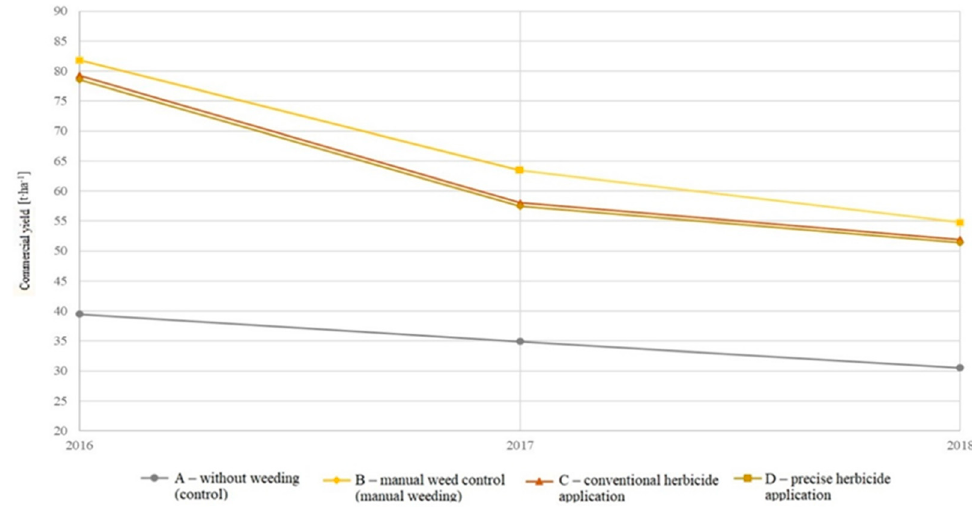
Figure 20. Reaction of commercial yield to changes in weather conditions depending on the weeding method (source: own work).